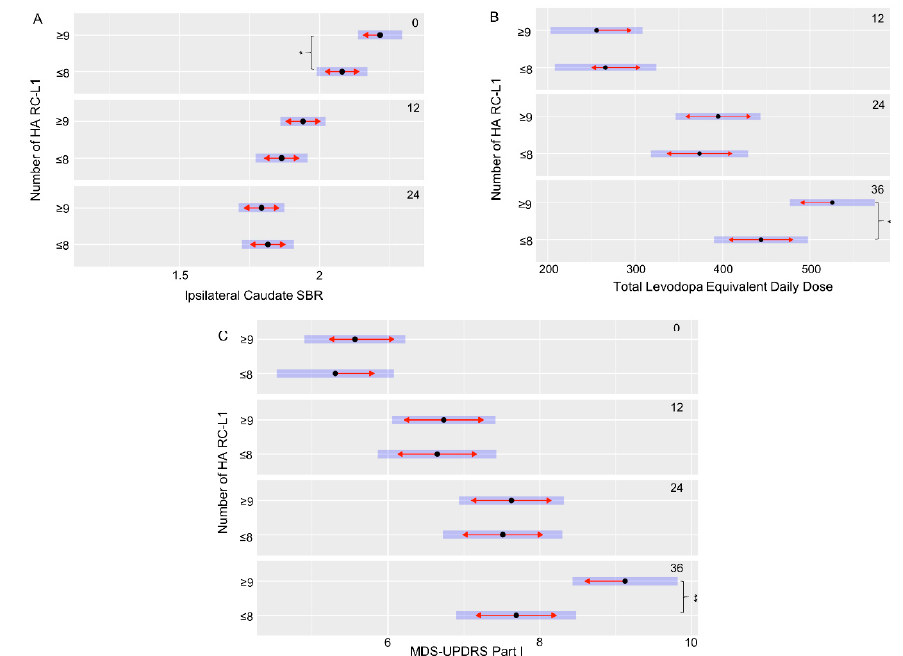
Figure 4. An increased burden of HA RC-L1s across the genome is associated with a significant increase in markers of Parkinson’s disease progression. ( A ) PD subjects with ≥ 9 RC-L1s had a significantly lower ipsilateral caudate SBR than those with ≤ 8 RC-L1s at baseline (0 months) ( p = 0.03). ( B ) PD subjects with ≥ 9 RC-L1s had a significantly higher mean total levodopa equivalent daily dose than those with ≤ 8 RC-L1s at 36 months ( p = 0.03). ( C ) PD subjects with ≥ 9 RC-L1s had a significantly higher mean MDS-UPDRS part I score than those with ≤ 8 RC-L1s at 36 months ( p = 0.008). Black dots represent the mean, the blue bars are the 95% confidence intervals and red arrows are the comparison arrows between the means. * p < 0.05 and ** p <